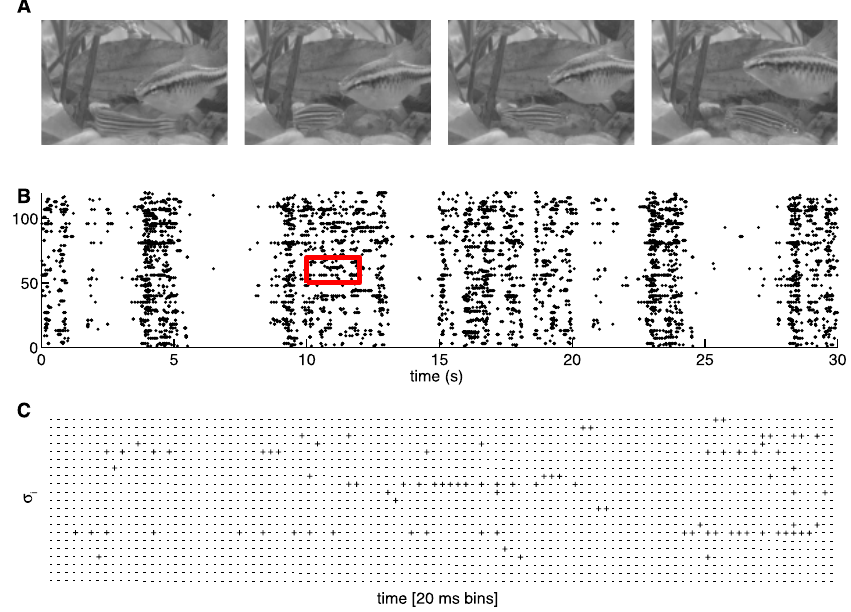
Figure 1. A schematic of the experiment. ( A ) Four frames from the natural movie stimulus showing swimming fish and water plants. ( B ) The responses of a set of 120 neurons to a single stimulus repeat, black dots designate spikes. ( C ) The raster for a zoomed-in region designated by a red square in (B), showing the responses discretized into D t =20 ms time bins, where s i ~{ 1 represents a silence (absence of spike) of neuron i, and s i ~z 1 represents a spike.